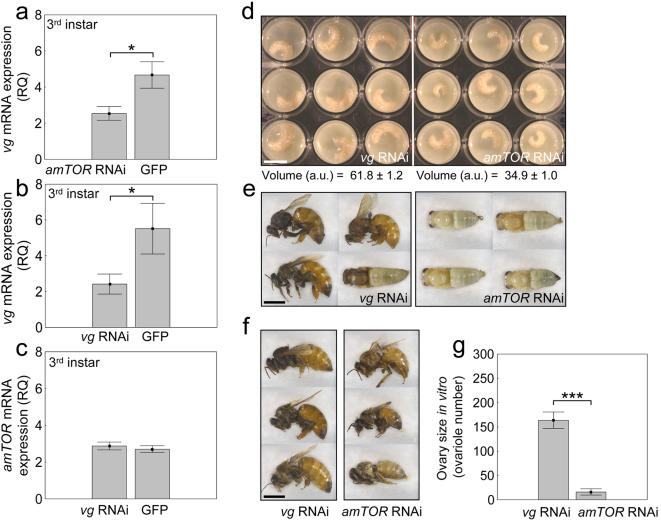
Control experiment comparing amTOR suppression (amTOR RNAi) with vitellogenin suppression (vg RNAi).In 3rd instar larvae, vitellogenin mRNA a, was reduced by amTOR RNAi. Yet when b, vitellogenin was similarly suppressed by vg RNAi, amTOR c, remained unaffected. Thus, vg RNAi is an unconfounded control for amTOR RNAi. In comparison to vg RNAi, amTOR RNAi: d, reduced larval growth (exemplified by 5-day-old larvae, larval volume is mean±s. e., arbitrary units); and delayed development (days until adult emergence: vg RNAi, 20.14±0.14; amTOR RNAi, 24.00±0.58) – also shown in e, a snapshot of phenotypic variance (20-day-olds), which demonstrates that vg RNAi bees had emerged with queen characters or had advanced pupal pigmentation; while amTOR RNAi bees were pupae, lightly pigmented and small. f, adult size of the last vg RNAi bees to emerge (21st day) vs. TOR RNAi bees (adult wet-weight mg: vg RNAi, 197.14±7.94; amTOR RNAi 119.67±12.03). In comparison to vg RNAi, amTOR RNAi also reduced ovary size g, (range vg RNAi: 62–210; amTOR RNAi: 4–26 ovarioles/ovary, ANOVA: F
1,8 = 118.92, P<0.00001). These data accurately replicate our comparison of GFP controls and amTOR RNAi (Fig. 3). Bars are means±s. e. (asterisk P<0.05). Scale bars d: 10 mm; e, f: 5 mm.